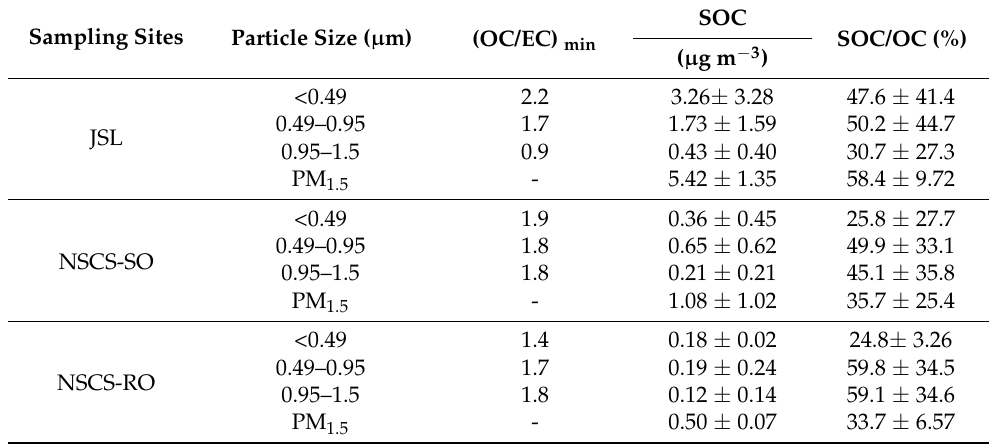
Table 3. Levels of second organic carbon (SOC) estimated from minimum OC/EC ratios. Sampling